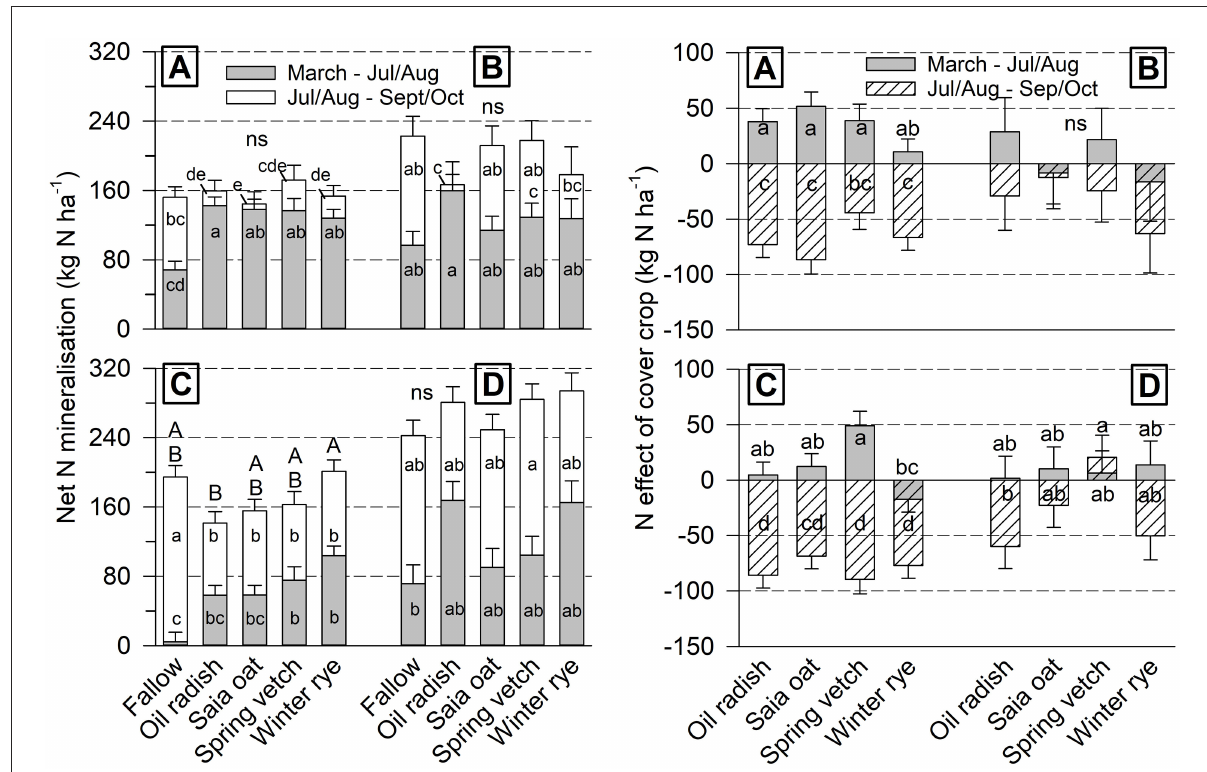
FIGURE2 Cover crop treatment effect on soil net N mineralization (left) and cover crop N effect (right) under unfertilized sugar beet in two periods of the growing season (mean of 4 replicates ± standard error) at Ihinger Hof 2018/19 (A) and 2019/20 (B) , and Göttingen 2018/19 (C) and 2019/20 (D) . Different lowercase letters indicate significant differences among cover crop treatments within single site/year combinations at p < 0.05 (Tukey-Kramer). Uppercase letters refer to the whole season from March to final harvest, ns not